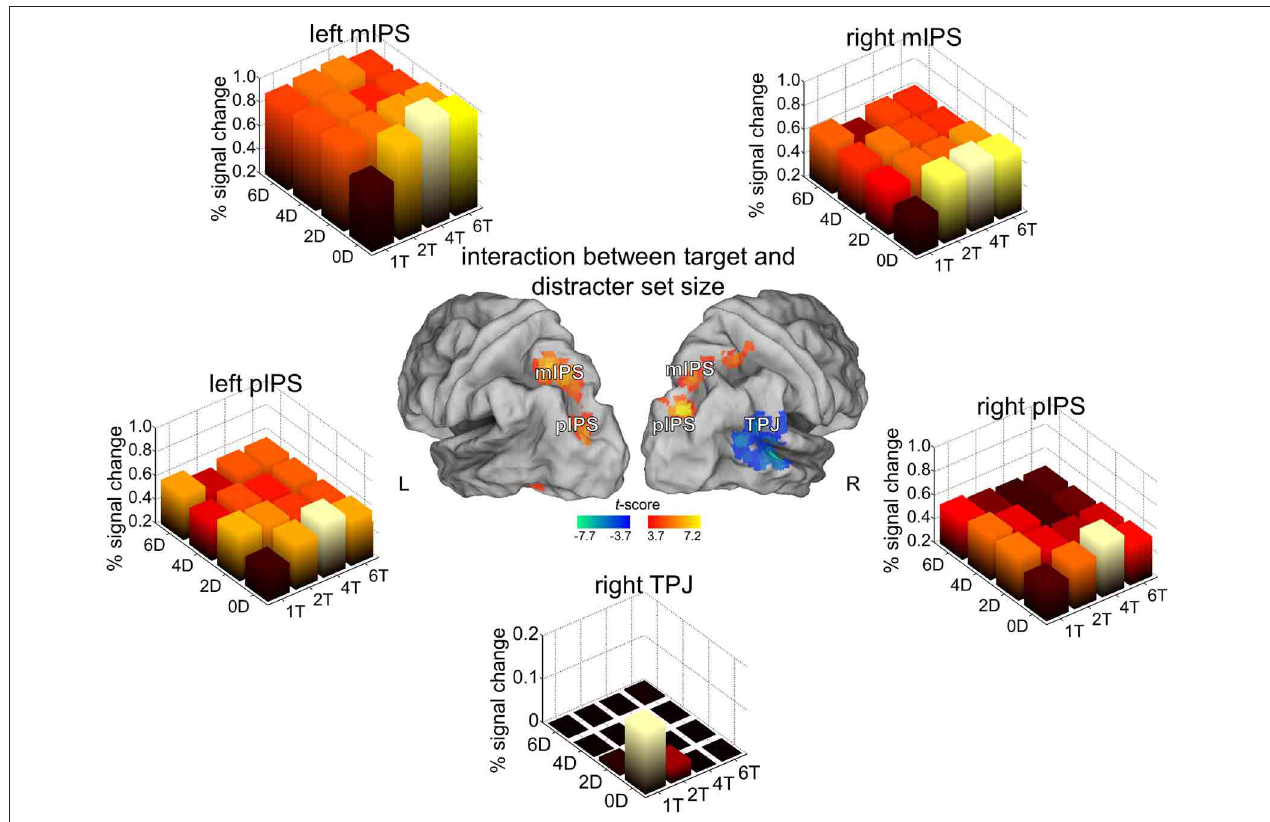
FIGURE 7 | Change detection paradigm. For the areas where an interaction was seen between target and distracter set size, the percentage signal increase is shown for the 16 different conditions of the factorial design. For further details Gillebert et al.